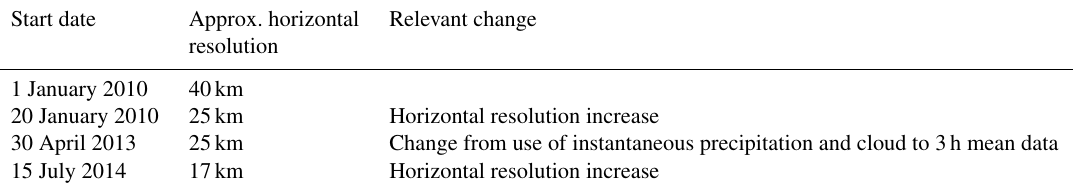
Table 1. Summary of the changes in the global UM data over the period of this study relevant to dispersion modelling. Start